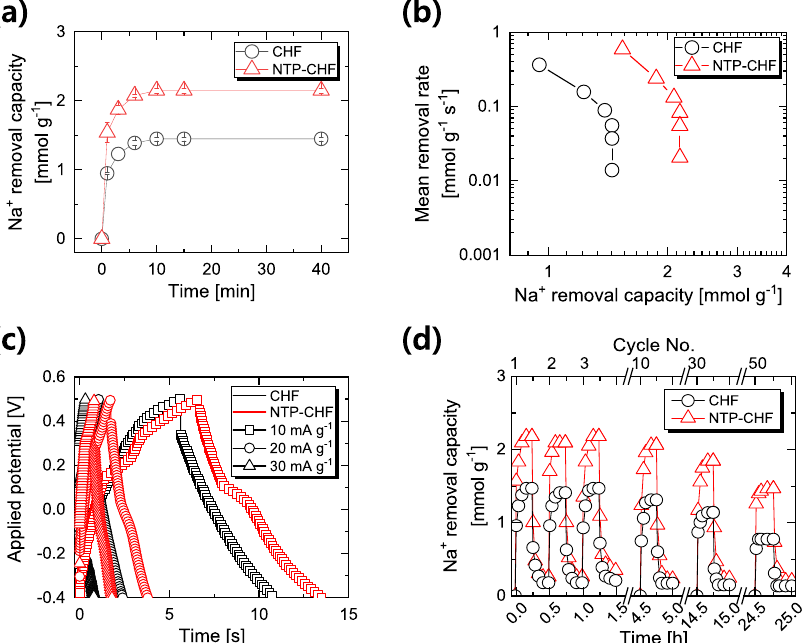
Fig. 5 Na + adsorption/desorption characteristics of hollow- fi ber electrodes under 8.6 mM NaCl solution. a Adsorption kinetics, ( b ) Ragone plot, ( c ) Galvanostatic curves for NTP-CHF at various current densities, and ( d ) Cyclic adsorption-desorption curve.